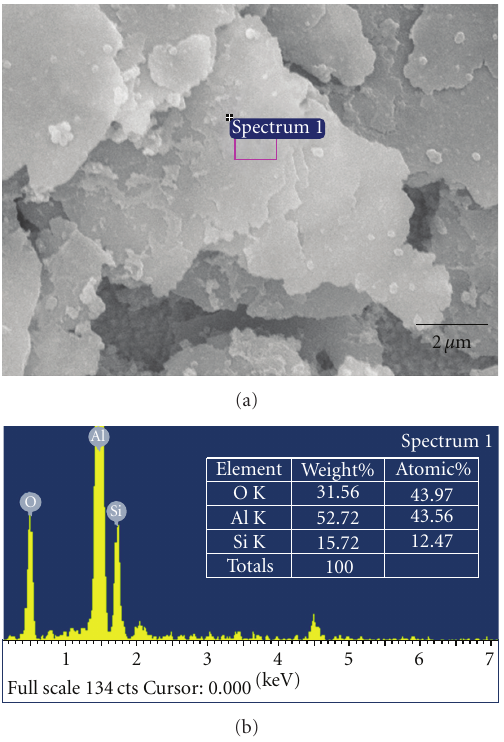
Figure 2: Characterization of Al@SiO 2 core-shell microflakes: (a) FE-SEM image and (b) EDS